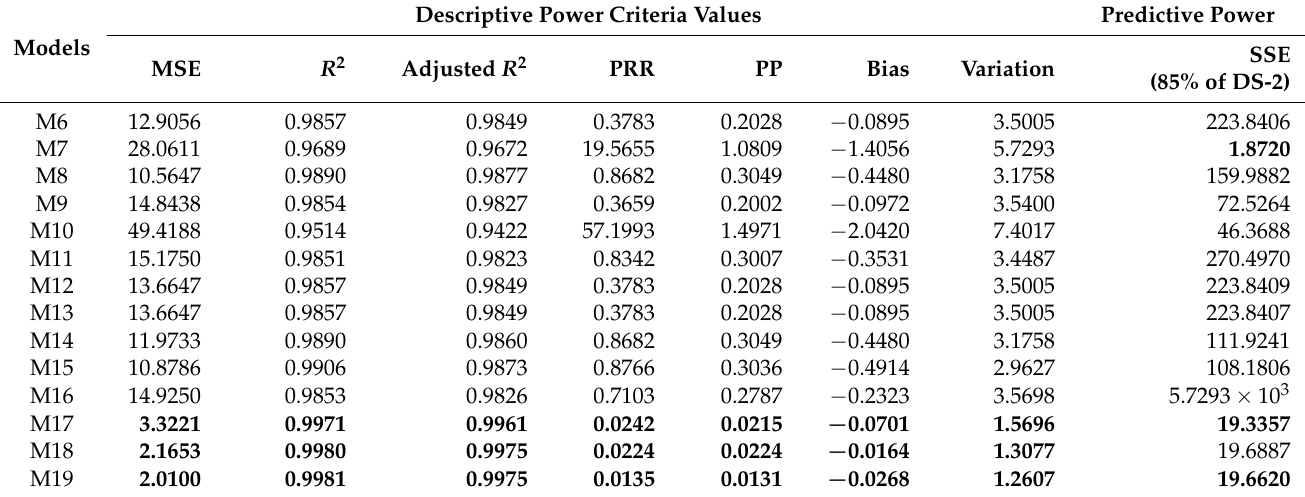
Table 5. Comparisons of descriptive and predictive power of M6 to M19 for DS-2.